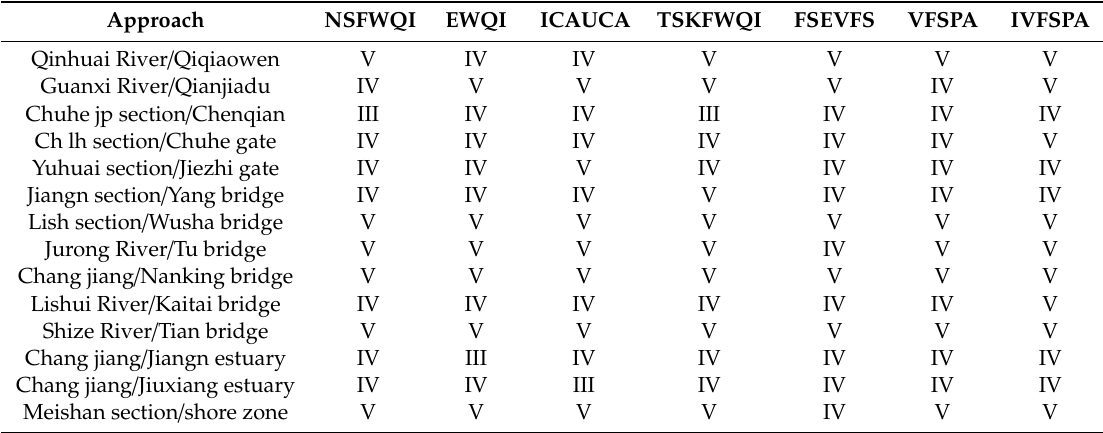
Table 5. Operation results of di ff erent